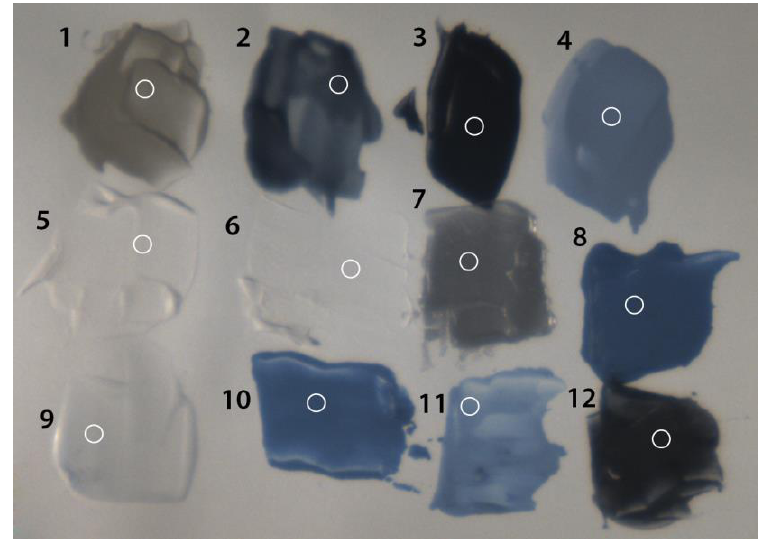
Figure 2. Light blocking at 735 nm.